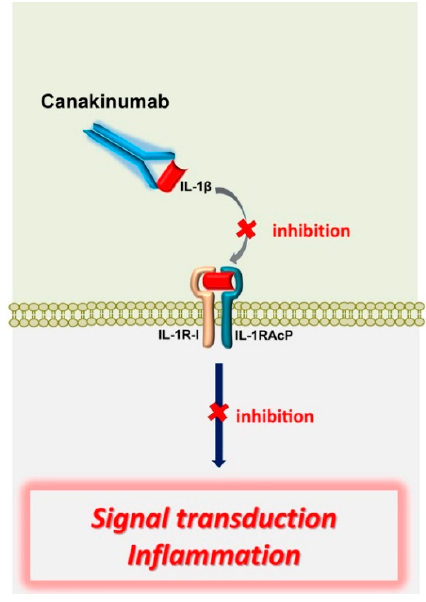
Figure 5. Mechanism of action of biologic agent canakinumab in FMF. Canakinumab is a fully human selective anti-IL-1 β monoclonal antibody and binds human IL-1 β . Subsequent binding of IL-1 β to the IL-1R is inhibited with prevention of intracellular signal transduction and further proinflammatory events. Abbreviations: IL, interleukin; IL-1R-I, interleukin-1 receptor, type1; IL-1RAcP, IL-1 receptor accessory protein. Adapted from